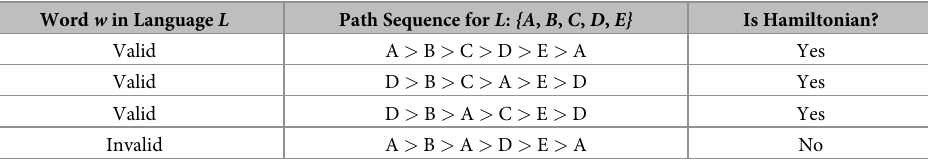
Table 1. Solution sample of valid and invalid candidates for a given string